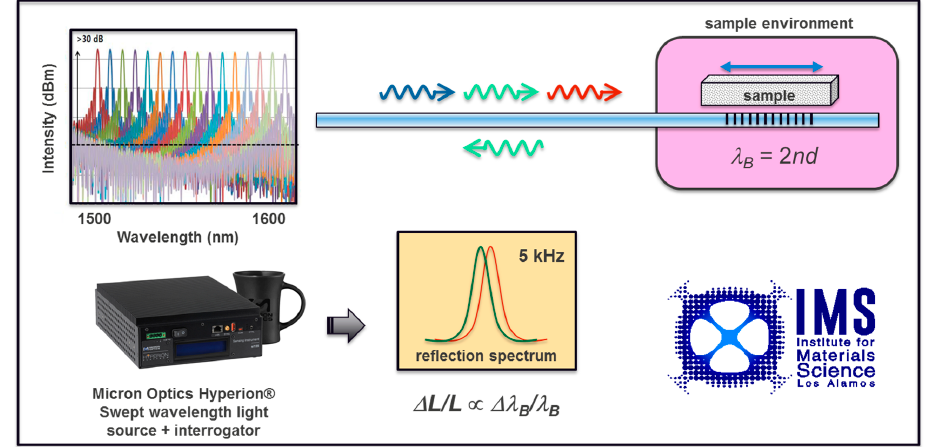
Figure 2. Experimental setup for fiber Bragg gratings (FBG) interrogation with a swept wavelength laser source, such as the Micron Optics Hyperion ® instrument. λ B is the Bragg wavelength, n is the fiber’s index of diffraction, and d is the grating